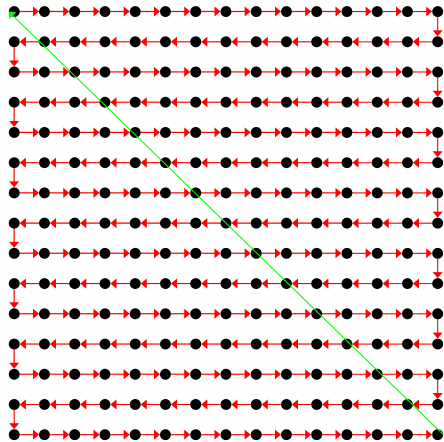
Figure 3. MEMS mirror adapting a bidirectional raster scan